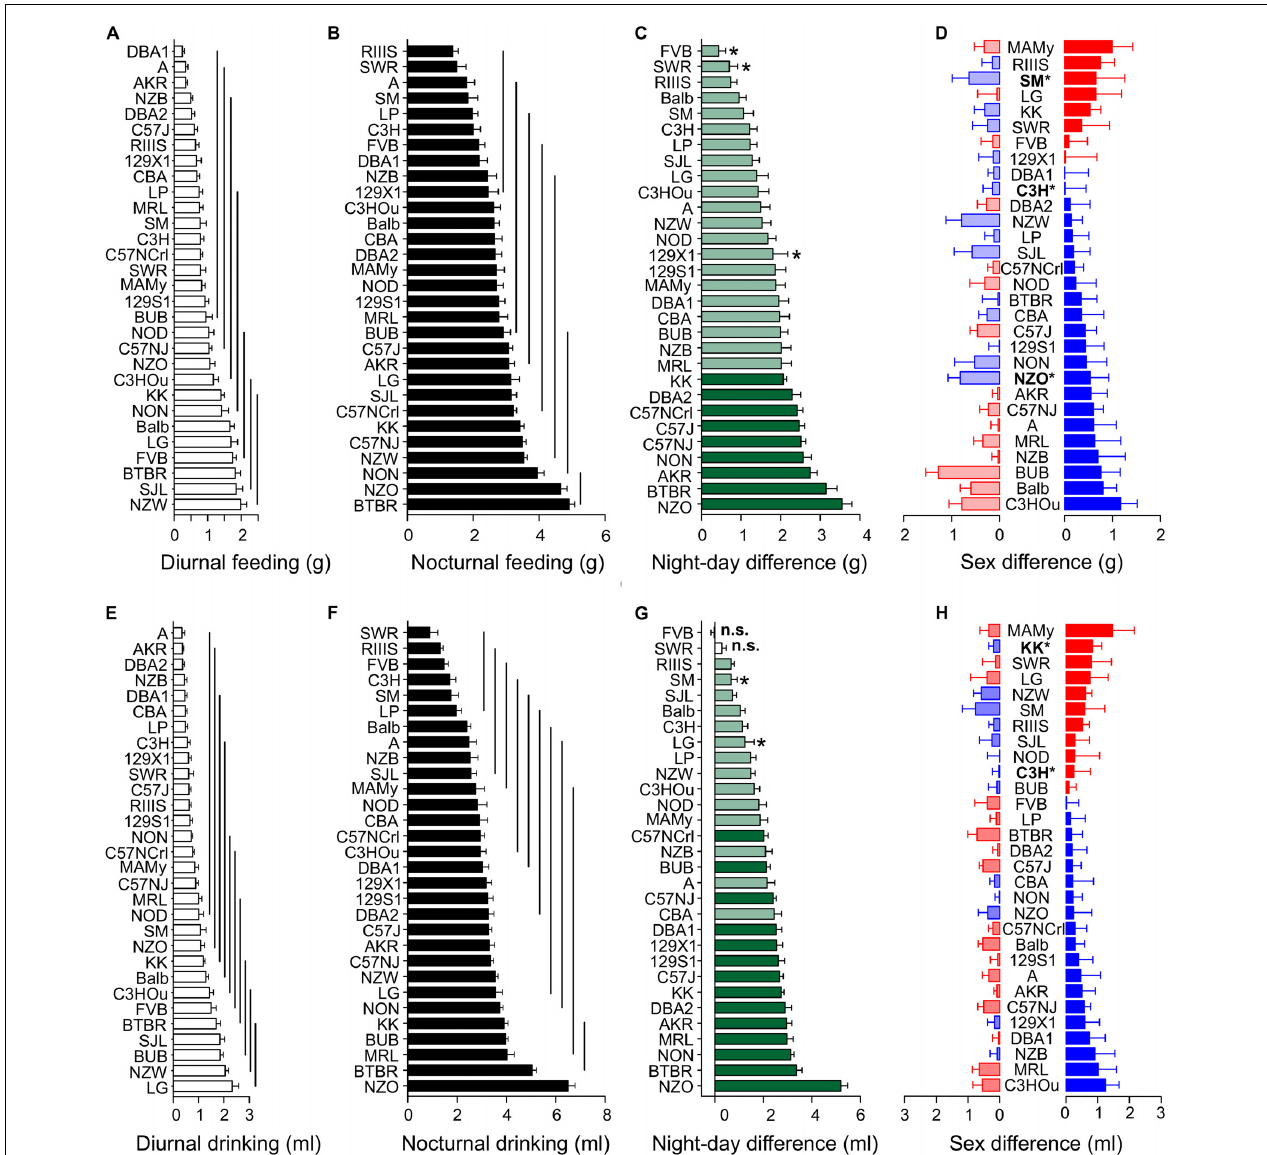
FIGURE 2 | Food and water intake are strain-dependent but not sexually dimorphic. Distribution of diurnal (A,E) and nocturnal (B,F) feeding (A,B), and drinking (E,F) behavior among 30 inbred strains. The values are given as mean ± SEM averaged from both sexes. The vertical lines in (A,B,E,F) connect groups with homogenous means according to Tukey’s post hoc test. (C,G) Day–night differences were ranked and Cohen’s D calculated. Significant differences at p < 0.03 are indicated with asterisk and p -levels < 0.001 were not marked; “n.s.” not significant. The effect sizes ranged between D = 0.46 (FVB, drinking) and 4.54 (NON, drinking) and are illustrated in light green ( D = 0.46 and D < 2) or in dark green ( D ≥ 2). (D,H) Sex differences were only apparent for food intake in three strains at a p -level of p < 0.05. The strains are ranked from largest to smallest sex difference for the scotophase, beginning, at the top, with strains, where females (red) consumed more water or food than males, while blue columns illustrate the opposite. To the left, nocturnal values are associated with the respective diurnal values and are displayed in light colors. All values are displayed as means ± standard error of the difference. Asterisks and bold font indicate significant sex differences, * p < 0.05.